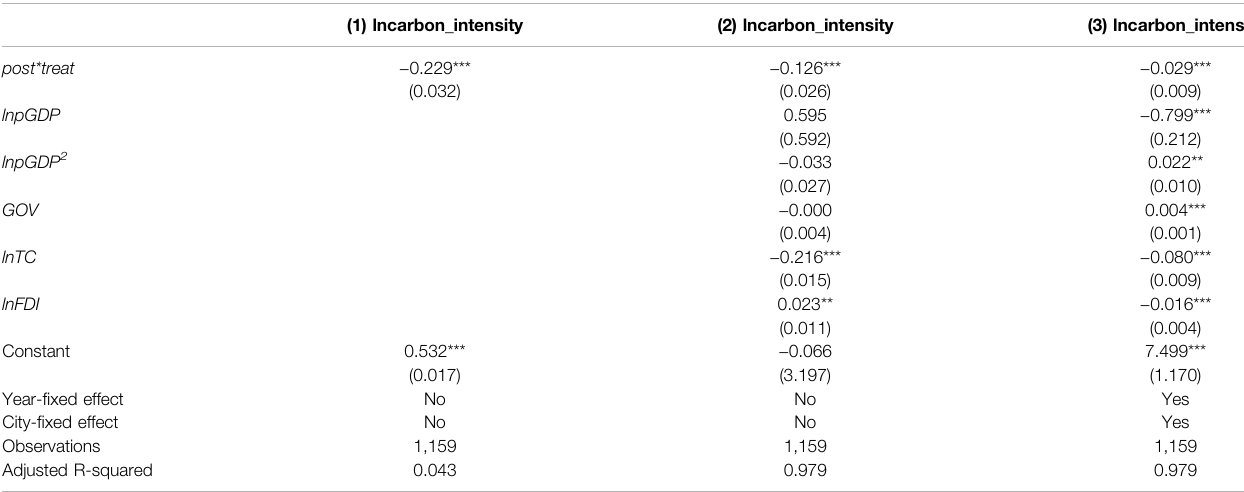
TABLE 2 | Baseline regression results. (1) lncarbon_intensity (2) lncarbon_intensity (3)